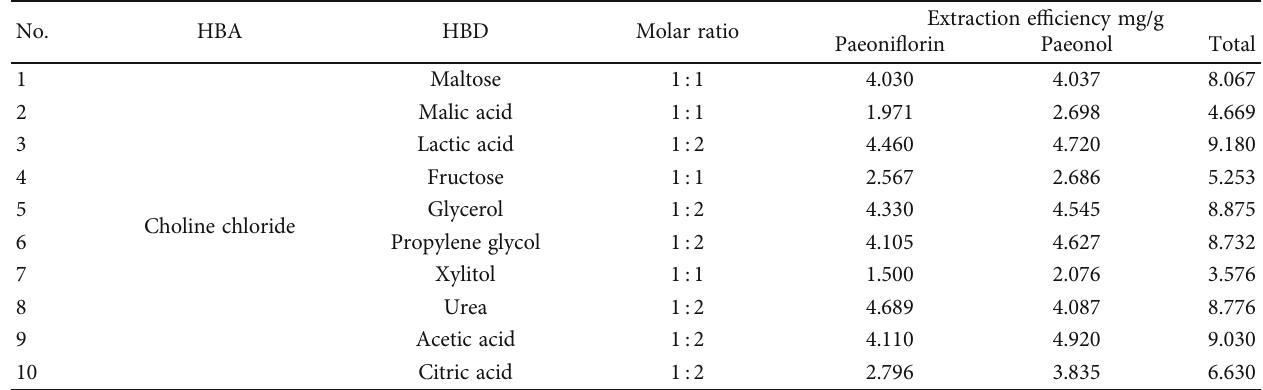
Table 1: Di ff erent types of DESs.